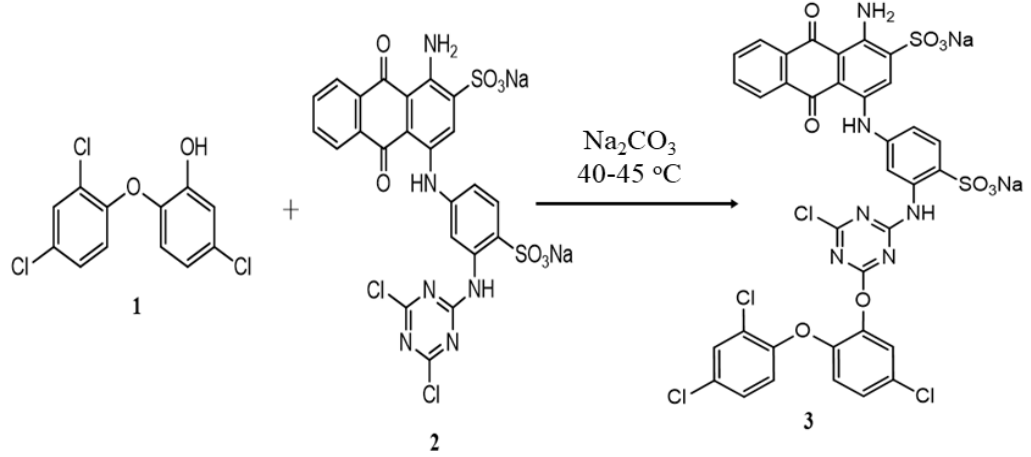
Figure 1. Antibacterial functionalization of Reactive Blue 4 dye with triclosan.